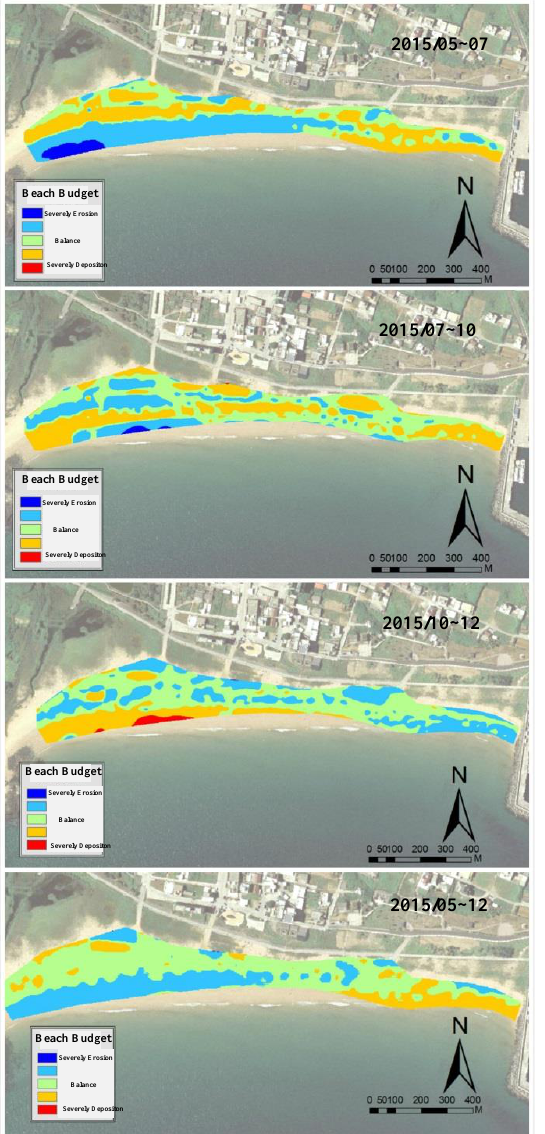
Figure7. Multiple time series of beach budgets